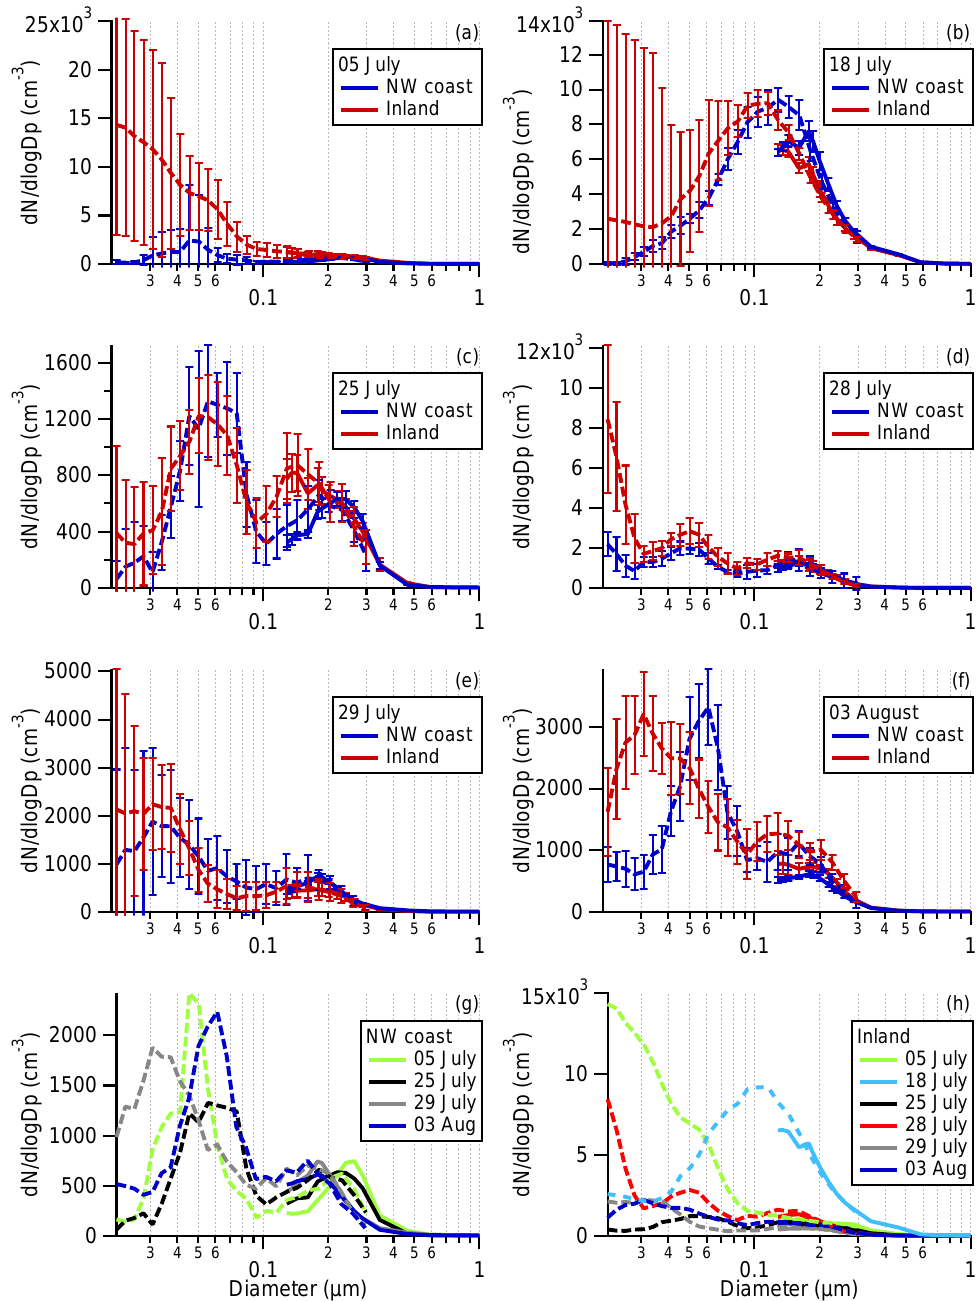
Figure 3. Submicron aerosol size distributions measured by the SMPS (dashed lines) and PCASP (solid lines) probes aboard the BAe-146. Panels (a) – (f) show the inland and NW coast distributions for each of the case study flights, while (g) and (h) show comparisons of all the NW coast and inland distributions respectively. The error bars in (a) – (f) show the standard deviations over each measurement